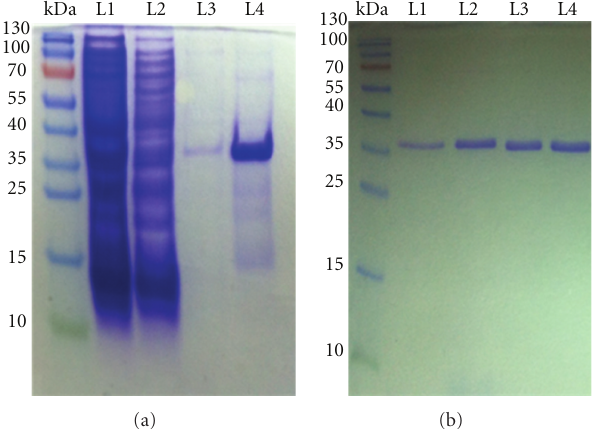
Figure 1: Production of single chain protease NSB2- ( G 4 - T - G 4 ) -NS3pro in E. coli . (a) The recombinant NS2B-NS3pro was produced as soluble proteins and purified by nickel column. L1: cell lysate, L2: washing flow through, L3: elution 1, and L4: elution 2. (b) Further purification was applied using gel a ffi nity chromatography (95% of enzyme purity) L1 to L4: Elution 1 to 4. The activity of purified enzyme